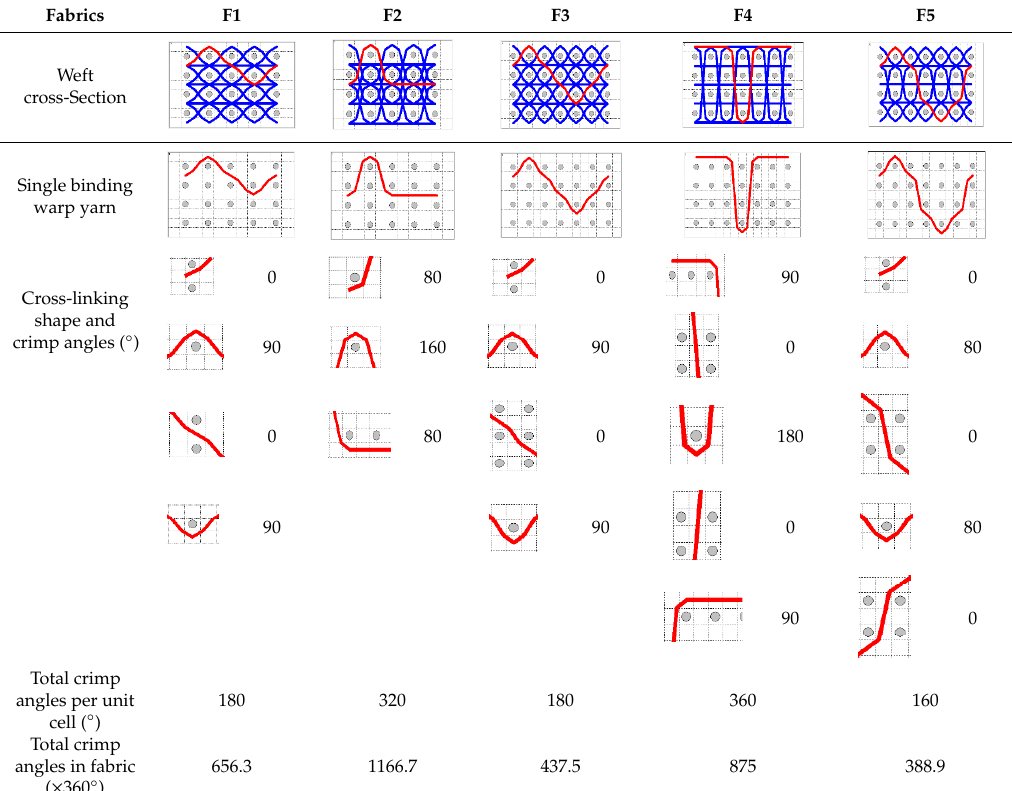
Table 6. The crimp angles between binding warp and weft yarns and the yarn interlacing shapes in different fabrics.